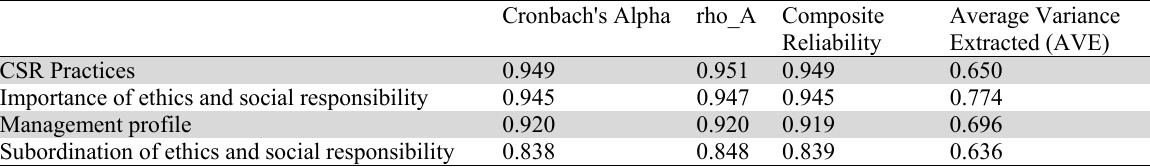
Construct Reliability and Validity